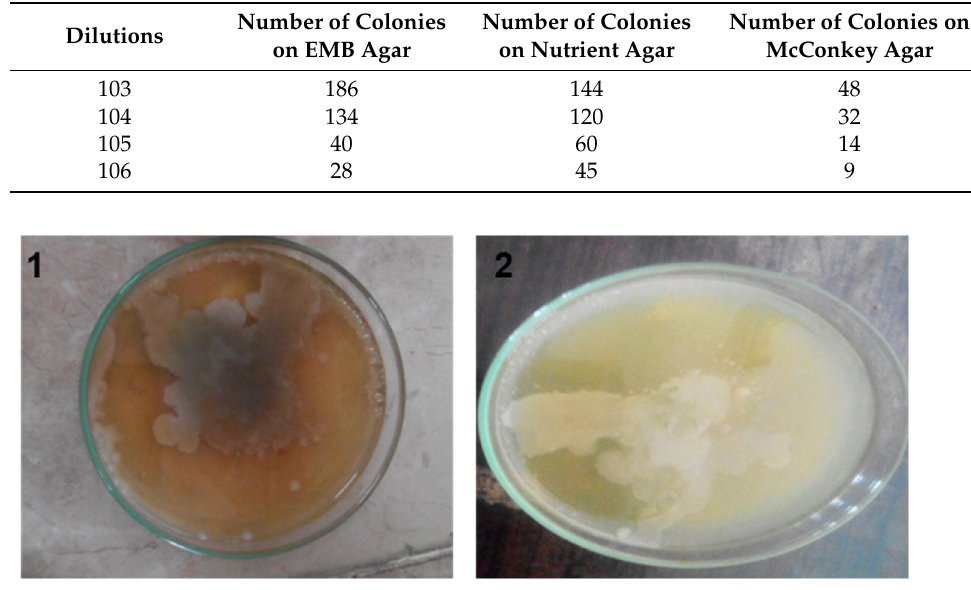
Figure 3. Colony formed on dilution 1st and 2nd on nutrient agar.